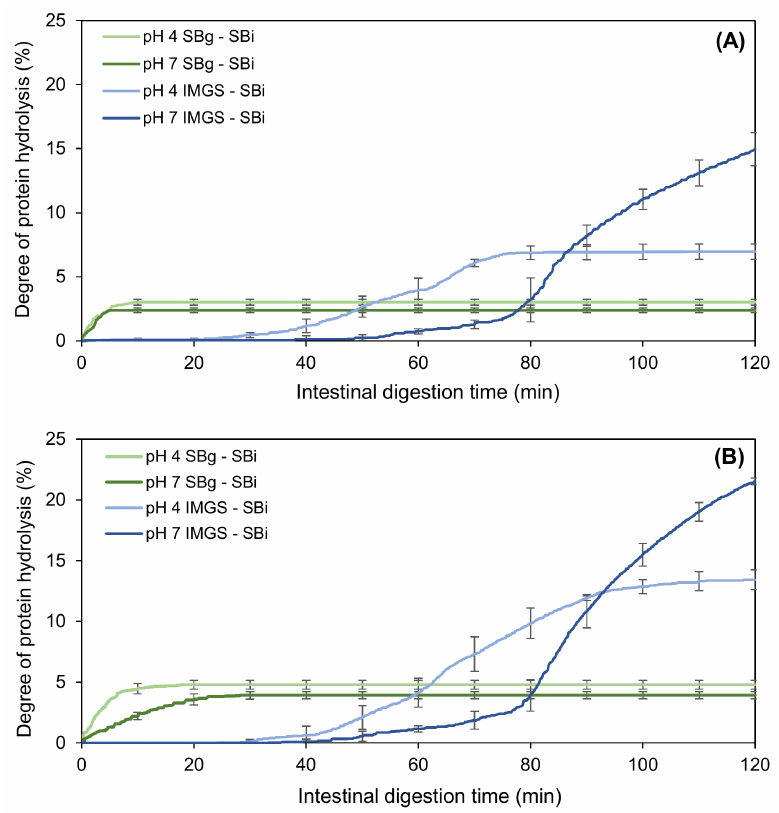
Figure 4. Kinetics of in vitro intestinal proteolysis using the systems IMGS–SBi and SBg–SBi for emulsion gels stabilized by WPI and fabricated at 500 bar ( A ) and 1000 bar ( B ). IMGS: In vitro mechanical gastric system; SBg: in vitro gastric digestion in a stirred beaker; SBi: in vitro intestinal digestion in a stirred